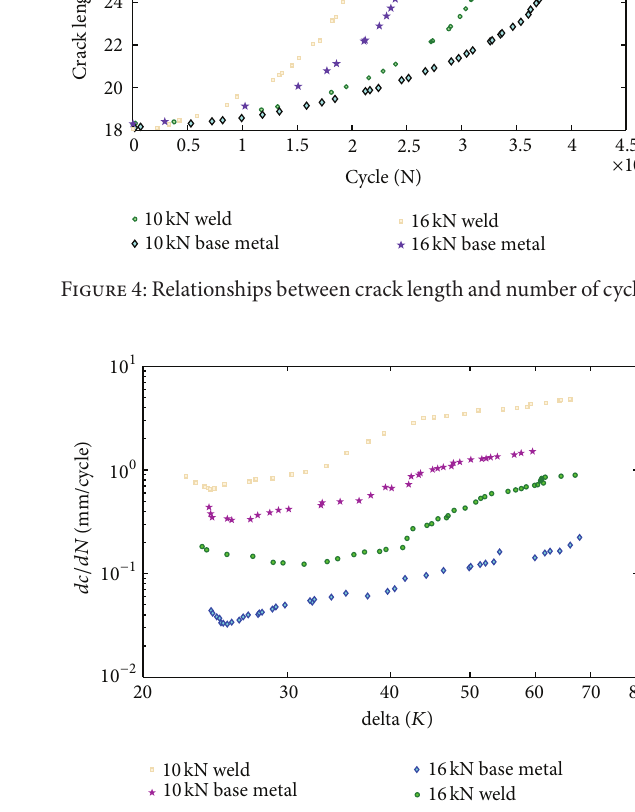
Figure 5: Relationship between cumulative count rate and stress intensity factor